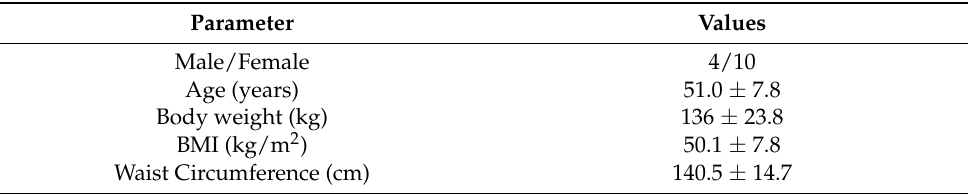
Table 2. Baseline characteristics of participants ( n =